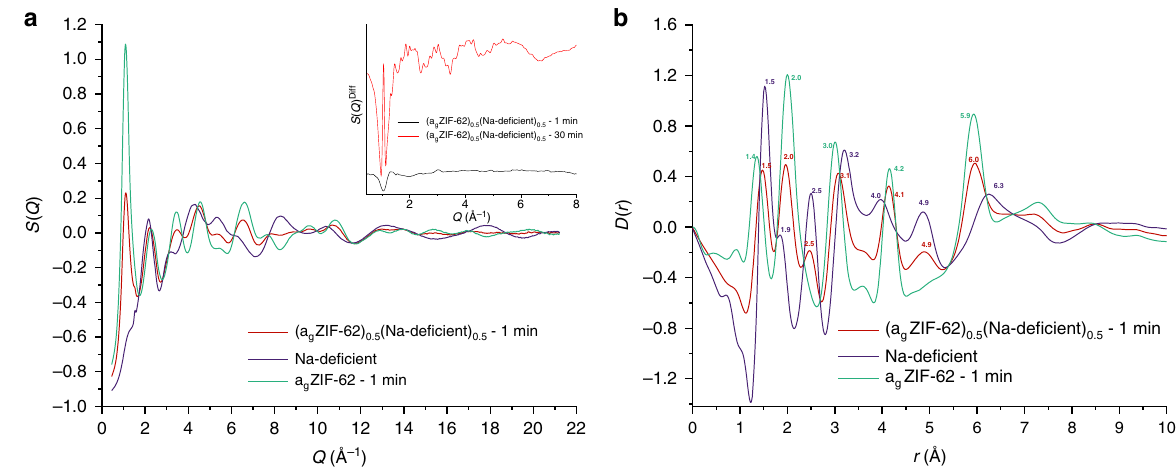
Fig. 8 X-ray PDF of (a g ZIF-62) 0.5 (Na-de fi cient) 0.5 – 1 min. a Total scattering of (a g ZIF-62) 0.5 (Na-de fi cient) 0.5 – 1 min, a g ZIF-62 – 1 min and Na-de fi cient glass, insert: sharpened difference of (a g ZIF-62) 0.5 (Na-de fi cient) 0.5 – 1 min and (a g ZIF-62) 0.5 (Na-de fi cient) 0.5 − 30 min samples with an offset applied for clarity (see main text). b X-ray pair distribution function of (a g ZIF-62) 0.5 (Na-de fi cient) 0.5 – 1 min, a g ZIF-62 – 1 min and Na-de fi cient